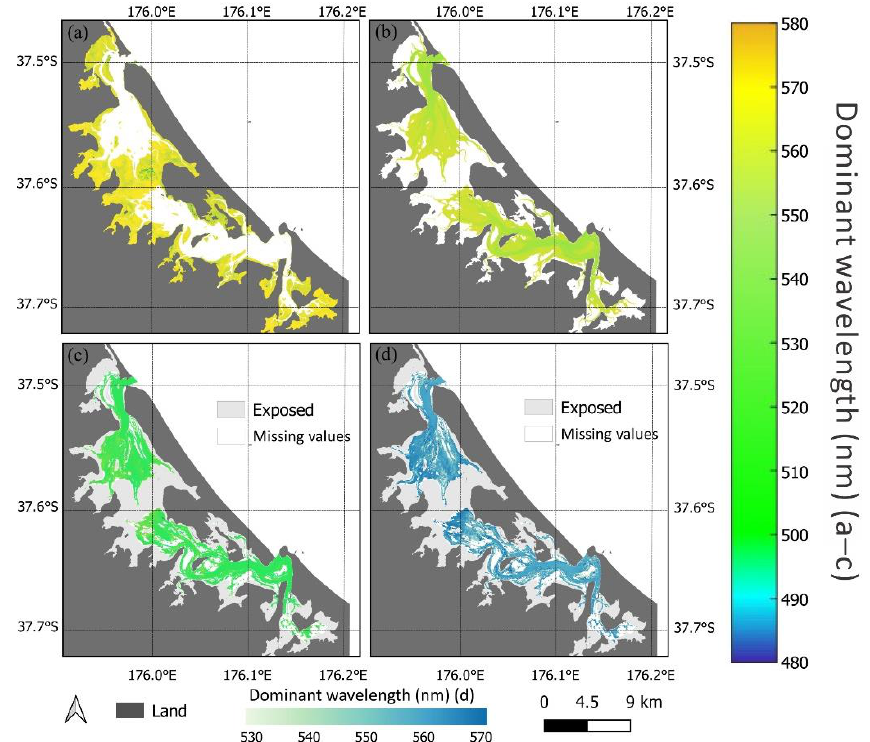
Figure 9. The dominant wavelength of exposed sediments ( a ) and underwater regions before ( b ) and after correction with the temporal method (applied monthly) in January 2019 ( c , d ). ( a ) The colour of exposed sediments not needing correction (the area of which varies with tidal state). ( b ) The monthly averaged dominant wavelength of the shallow and deep water prior to any correction. ( c ) The colour after correction of the optically shallow regions (deep water pixels are not corrected, R w ~ R ), where the colour scale (right) reflects the true dominant wavelength. ( d ) The same data as in ( c ), only with a different colour scale for readability (scale at the bottom). Consistent with Figure 8, the exposed regions and missing values are marked in grey and white, respectively. Table 3. The STD and n of the R ws in visible bands using four different tile sizes with spatial method (40, 60, 80 and 100 m),